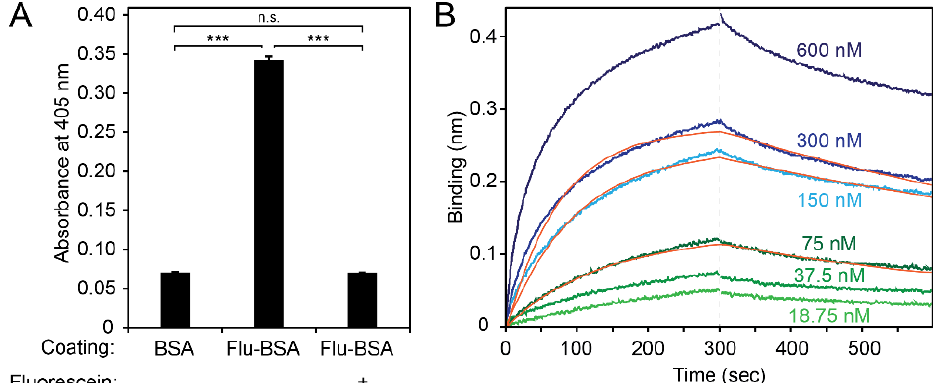
Figure 7. Fluorescein binding of the selected VHH-D4. ( A ) Binding specificity of VHH-D4. Wells were coated with BSA (negative control) or fluorescein-conjugated BSA and the binding of VHH (0.75 µg mL −1 ) was evaluated in the absence (−) or presence (+) of 1 mM free fluorescein. Mean values of three replicates ± SEM are shown. Statistical analysis: one-way ANOVA followed by Tukey’s multiple comparison test; *** p < 0.001; n.s., not significant. ( B ) Binding affinity of VHH-D4. Bio-layer interferometry sensorgram traces of the association and dissociation of VHH-D4 to/from fluorescein-conjugated BSA. Aminopropylsilane biosensors were loaded with fluorescein-BSA and association and dissociation of VHH-D4 at the indicated concentrations were monitored. The orange curves represent the global fitting according to a 1:1 bimolecular interaction.